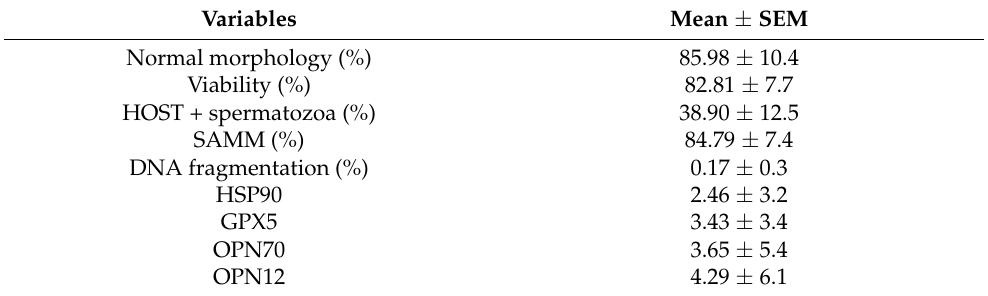
Table 3. Quality semen variables and proteins of sperm and seminal plasma of the 65 boar samples.